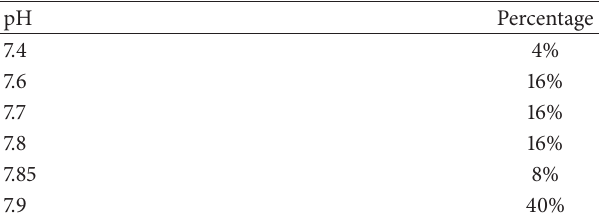
Table 4: p Η of hot shower (indirect